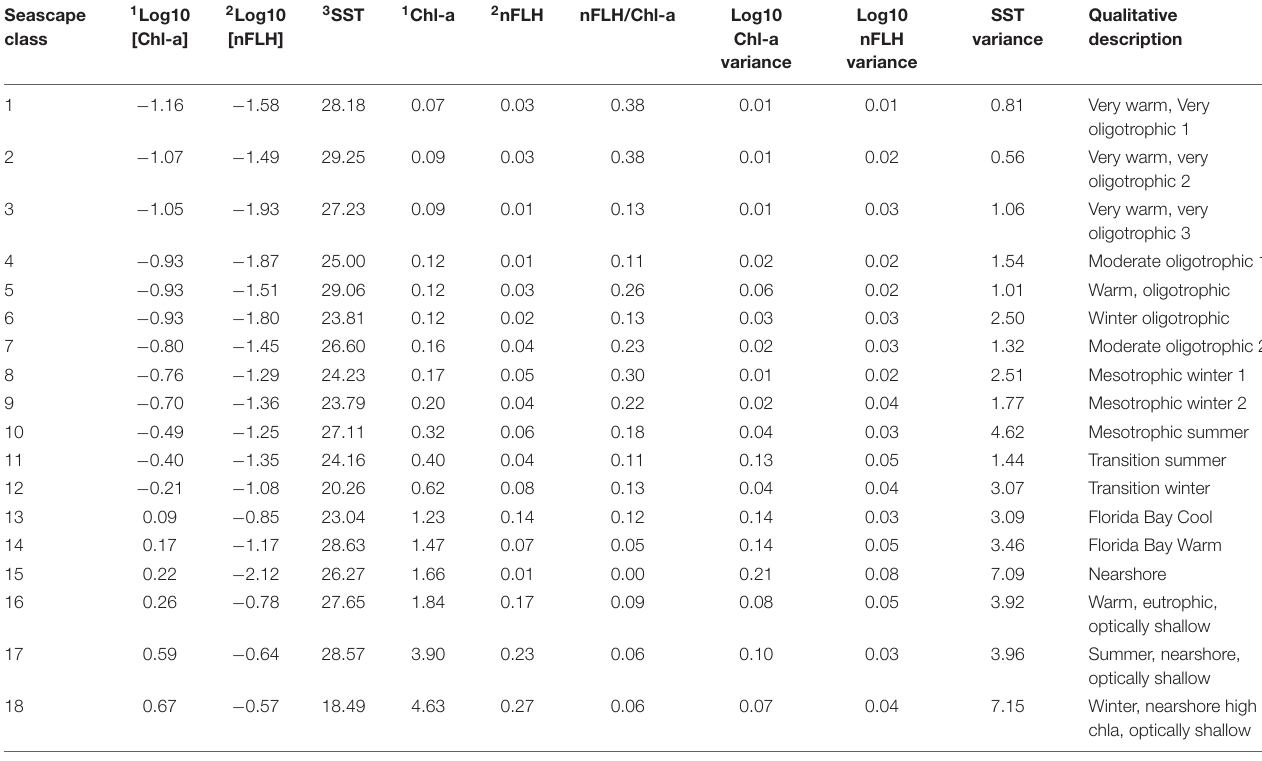
TABLE 1 | Mean and variance values of satellite input data for each seascape class with corresponding qualitative description. Seascape